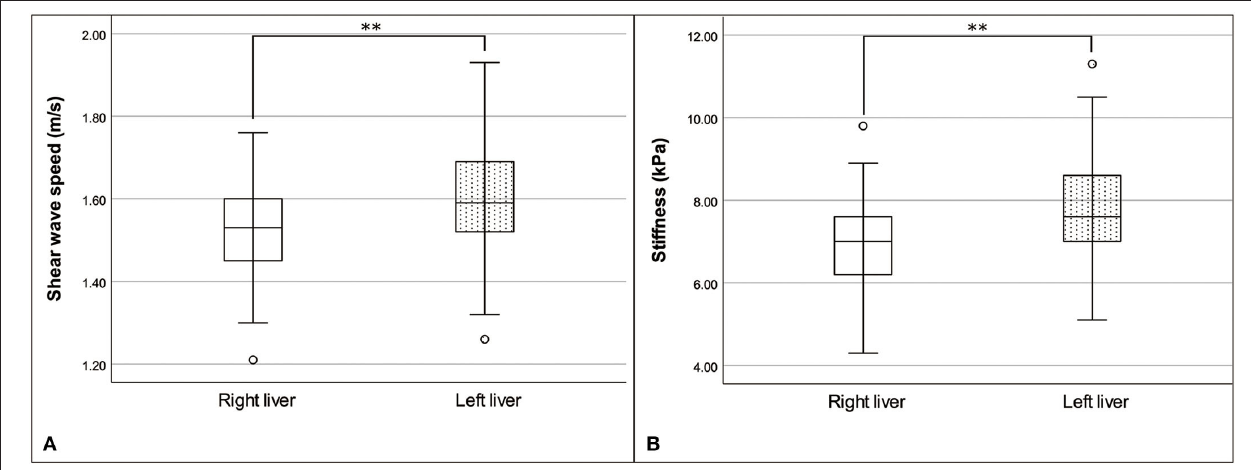
FIGURE 3 | Box and whisker plot of the median shear-wave speed (A) and stiffness (B) of the liver, with a comparison between the right and left liver. Shear-wave speed and stiffness were significantly different between the liver, by paired t -test; ** P <